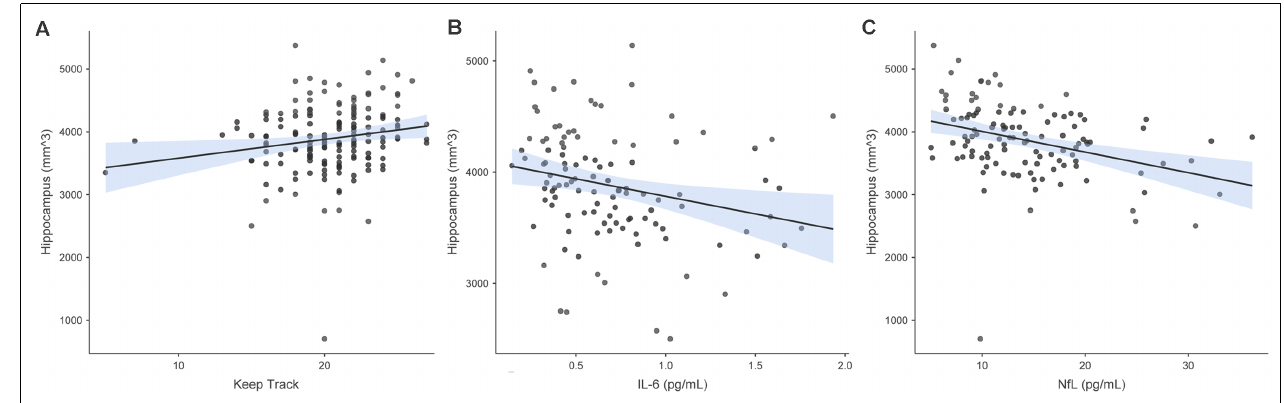
FIGURE 5 | Associations between hippocampal volume and Keep Track, IL-6, and NfL. Panel (A) shows the raw association between bilateral hippocampus volume and Keep Track. Panel (B) shows the raw association between bilateral hippocampus volume and IL-6. Panel (C) shows the raw association between bilateral hippocampus volume and NfL.